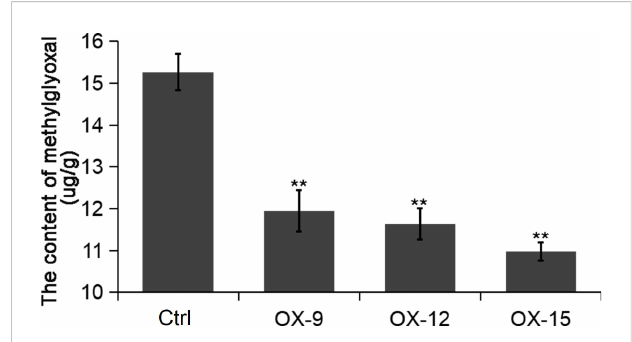
FIGURE 8 The content of methylglyoxal in the OsGF14C -OX transgenic plants and control plants (Ctrl). Error bars indicate the SD from three biological replicates and asterisks indicate statistically signi fi cant differences compared to the control plants ( t test, ** P <0.01).